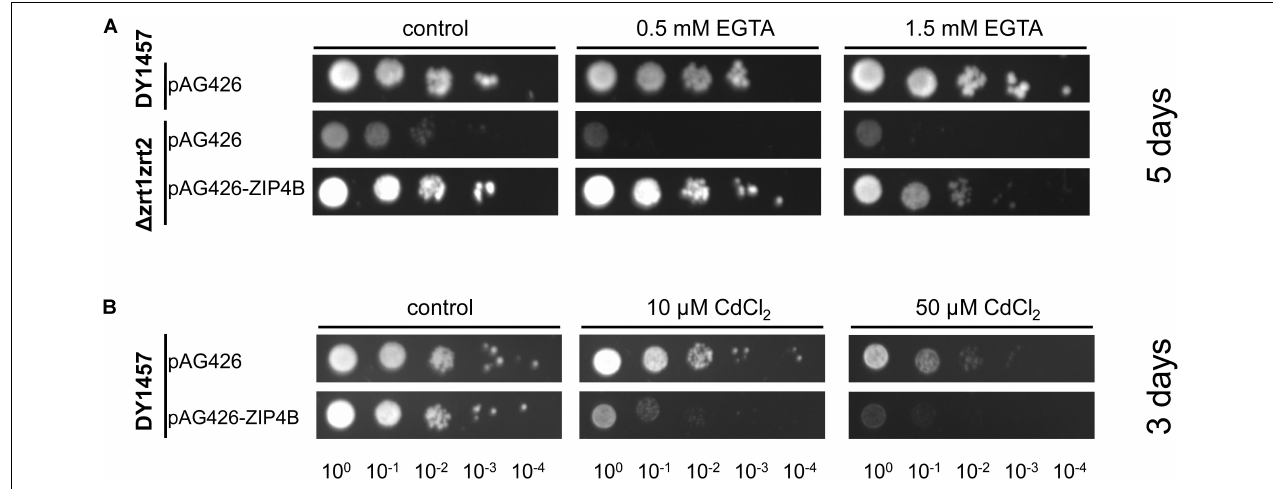
FIGURE 3 | Complementation by NtZIP4B cDNA of yeast mutants defective in metal uptake on selective media. Yeast cells: DY1457, (cid:49) zrt1zrt2 (defective in Zn uptake) were transformed with empty vectors pAG426 as a control, or with vectors carrying tobacco gene NtZIP4B with the stop codon pAG426-ZIP4B-STOP (pAG426-ZIP4B). Yeast cultures were adjusted to an OD600 of 0.2 and 5 µ l of serial dilutions (from left to right in each panel) was spotted on SC-URA medium containing 2% (w/v) galactose solidified with 2% agar, supplemented with EGTA (A) , CdCl 2 (B) or 0.2 mM Zn (control). The plates were incubated for 3–6 days at 30 ◦ C. The images are representative of three independent experiments taken after 5 days of growth (A) and 3 days of growth (B) .